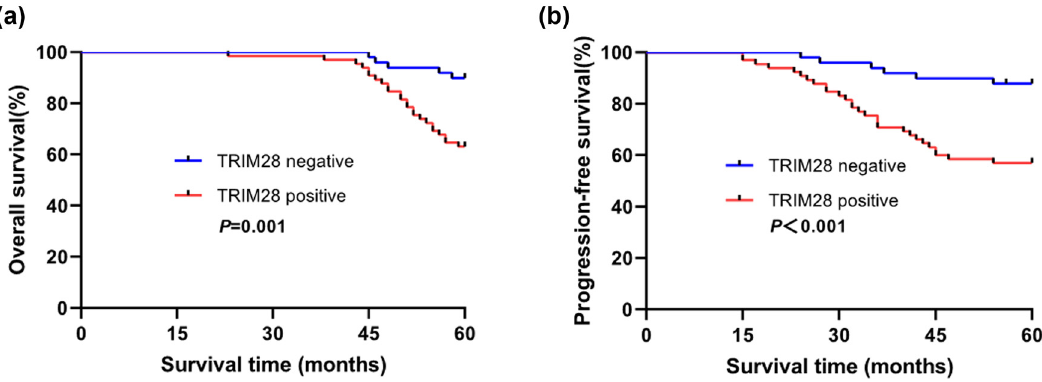
Figure 4: Kaplan - Meier survival analysis of high TRIM28 expression ( n = 49 ) and low TRIM28 expression ( n = 65 ) in BC patients. ( a ) The relationship between TRIM28 expression and overall survival rate ( P = 0.001 ) ; ( b ) The relationship between TRIM28 expression and progression - free survival rate ( P < 0.001 ) .